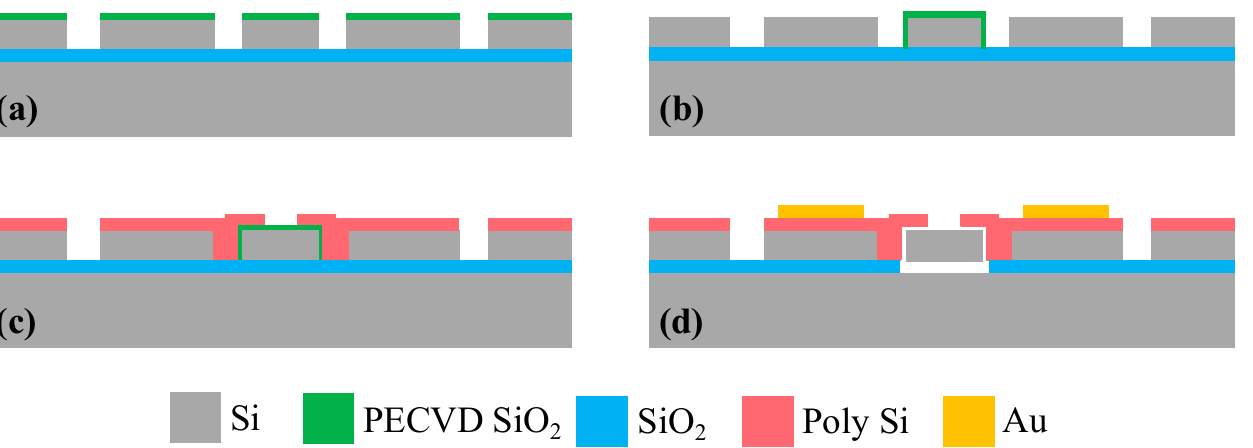
2 layer deposited